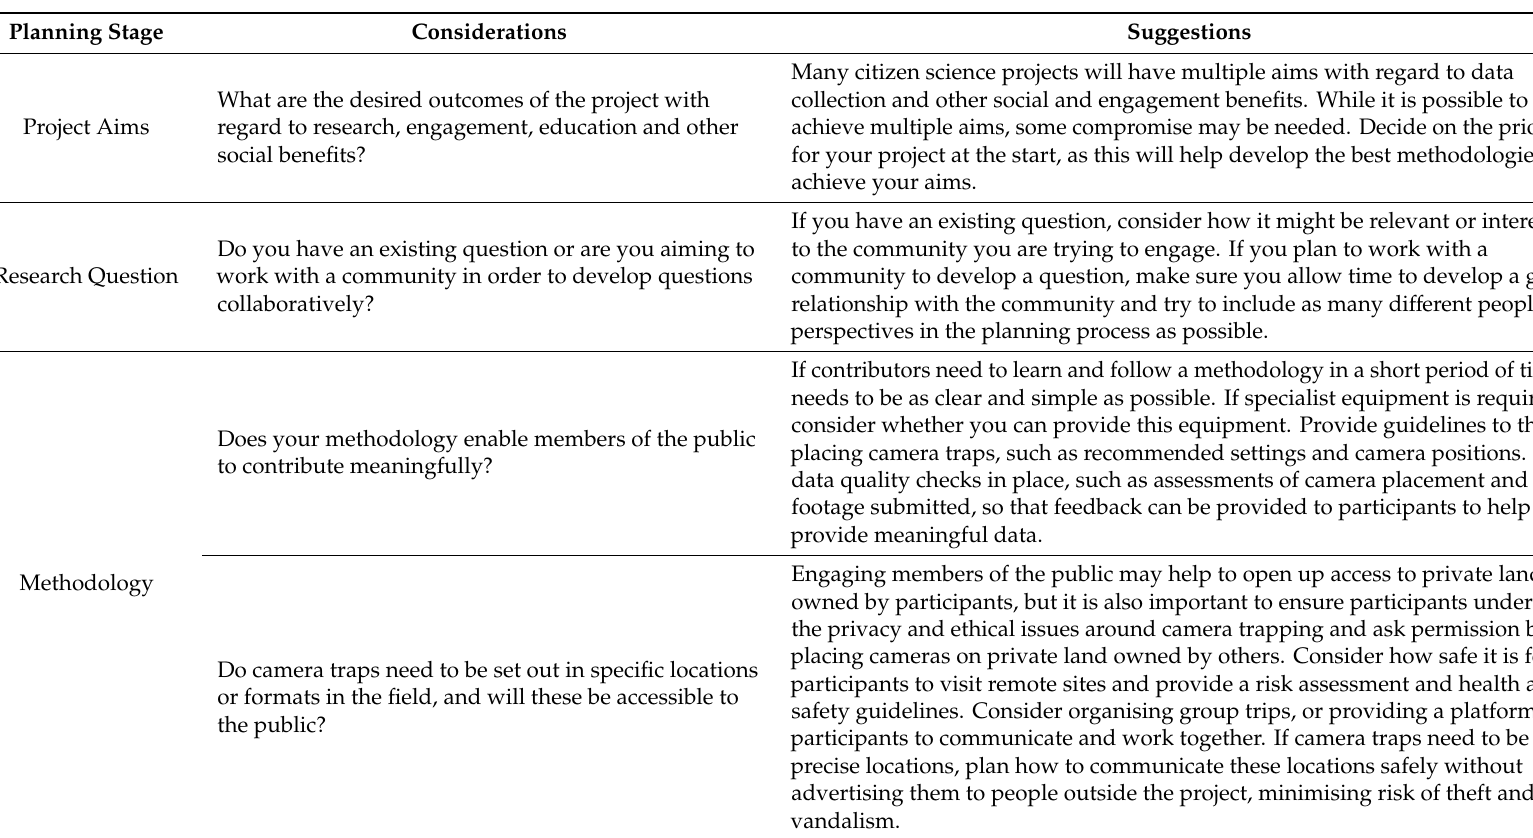
Table 1. Considerations for citizen science camera trap project